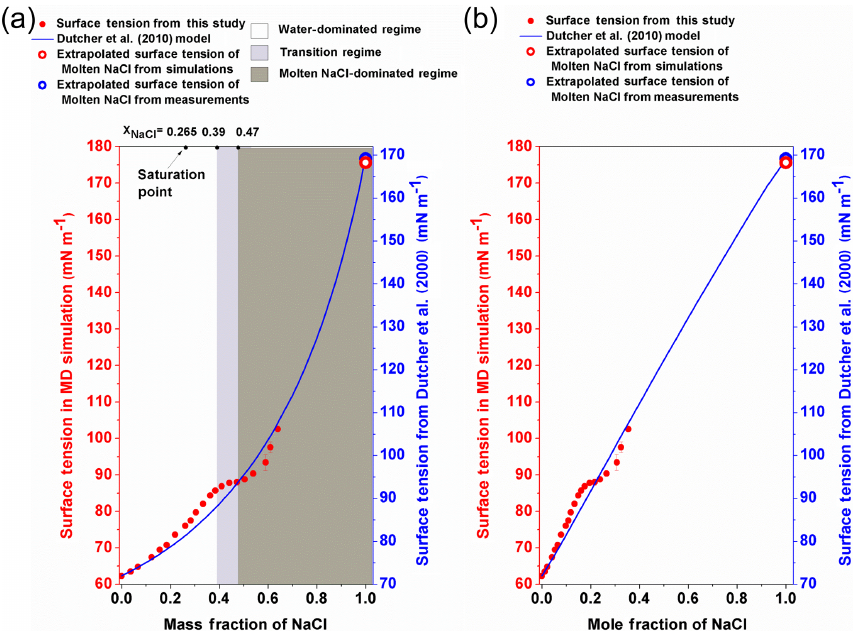
Figure 4. The surface tension of different-concentration NaCl solution. (a) The surface tension of NaCl solution against the mass fraction of NaCl. The left red y axis is for the data from MD simulation (red circle), and the right blue y axis is for the Dutcher et al. (2010) model (blue solid line). The white, light grey and dark grey areas shade the water-dominated, transition and molten NaCl-dominated regimes, respectively. (b) The surface tension of NaCl solution is plotted against the mole fraction of